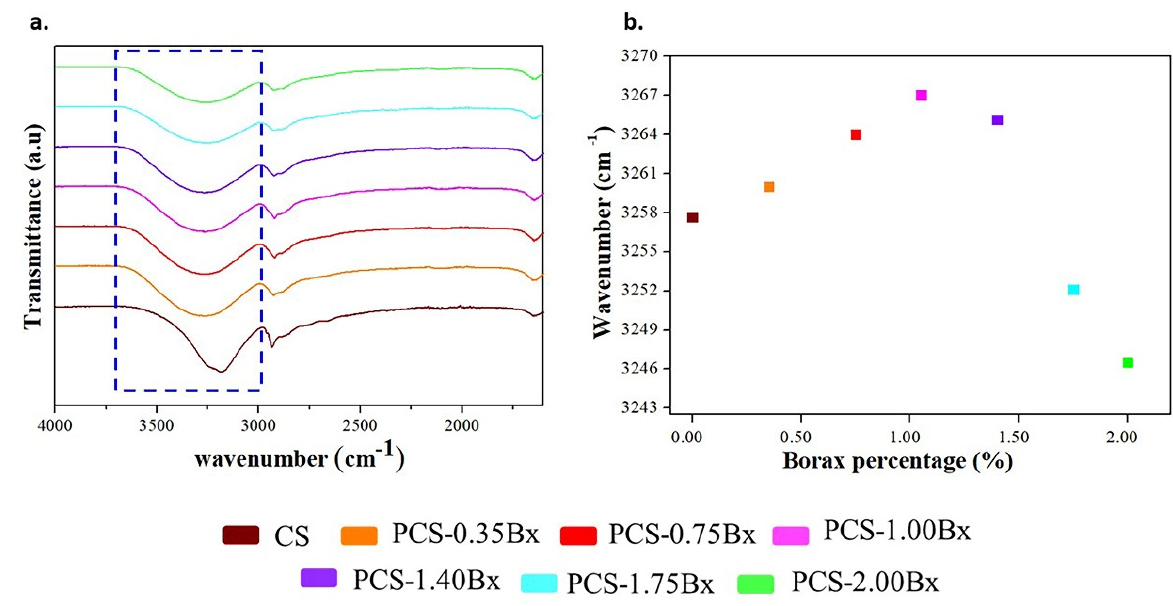
Figure 5. ( a ) FTIR spectrums of cassava starch biopolymer films with borax added. ( b ) Shifting of the band corresponding to the OH bonds shown in ( a ).